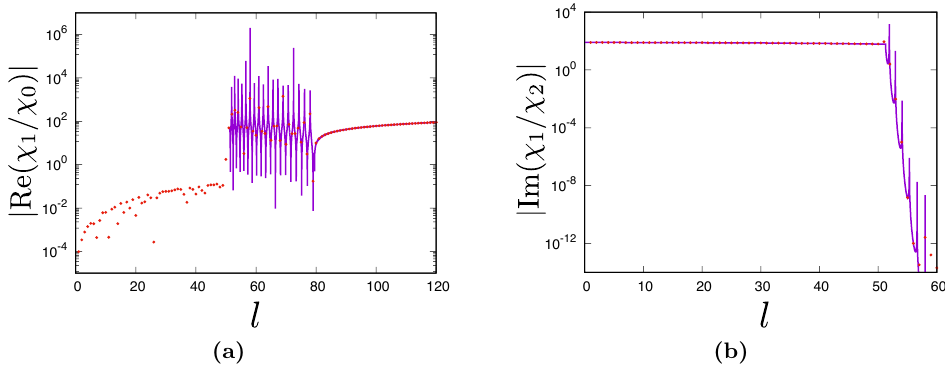
Figure 19 . Comparison of χ 1 /χ 0 for r h = 0 . 3 between WKB approximation (purple curve) and full numerical calculation (red dots). In the WKB analysis, the quantum number of the spherical harmonics l is regarded as a continuous parameter for